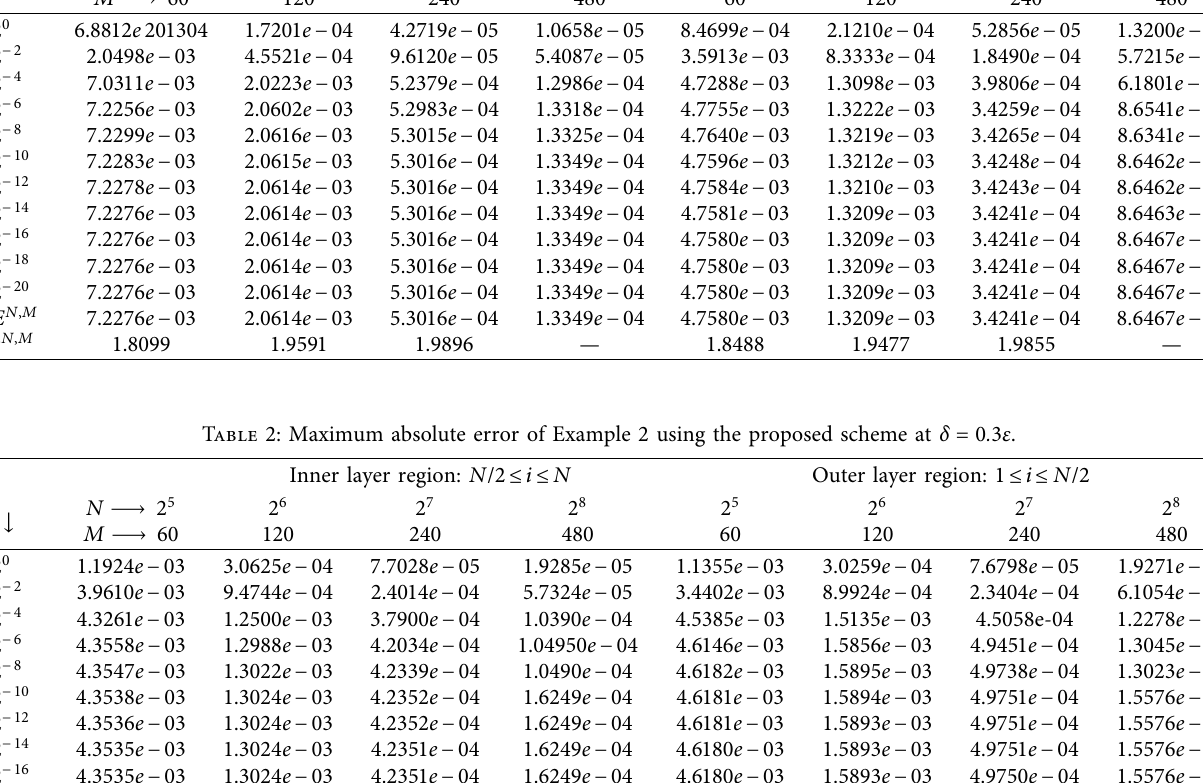
Table 1: Maximum absolute error of Example 1 using the proposed scheme at δ � 0 . 3 ε .